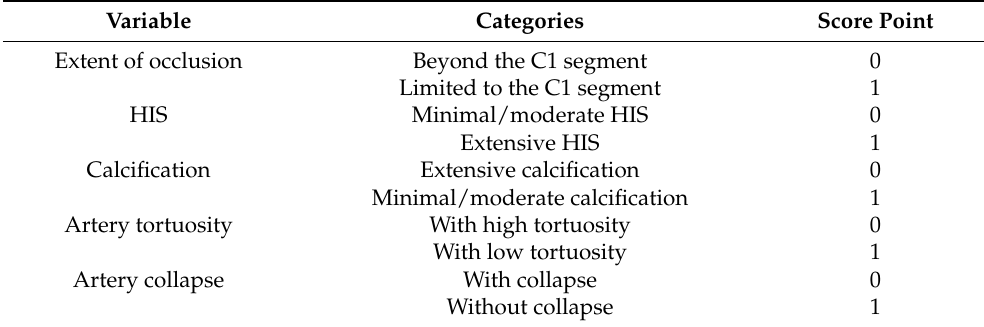
Table 4. Variables of the MR CICAO